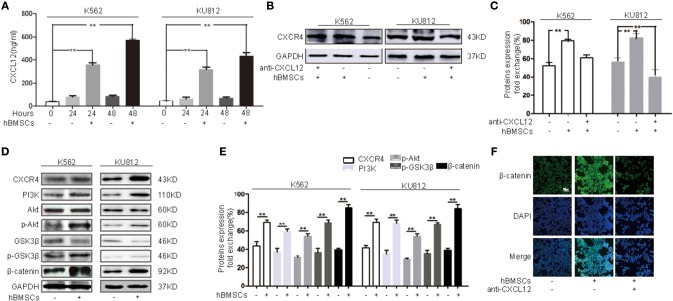
BM microenvironment stimulated CXCL12 secretion and activates CXCR4 in CML cells. K562 and KU812 cells were cultured with or without hBMSCs for 24 h or 48 h. (A) ELISA assay detection of CXCL12 secretion in CML cells co-cultured with BMSCs. (B) Western blot analysis of expression after cells co-cultured with BMSCs and Neutralizing CXCL12 (10 μg/ml). (C) Analysis of proteins expression. (D) The expression of downstream protein of CXCR4 was analyzed by western blot analysis. (E) Analysis of proteins expression. (F) Immunofluorescence detection of the distribution of β-catenin in K562 cells. Data (A,C,E) were shown as Means ± SD for three independent experiments (*p < 0.05 and **p < 0.01).